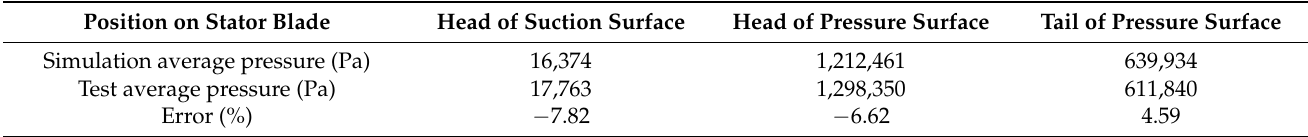
Figure 38. Errors of turbine torque, torque ratio, efficiency, and capacity constant between modified cavitation model and test at various speed ratio under cavitating conditions. Table 5. Pressure data at different locations on stator